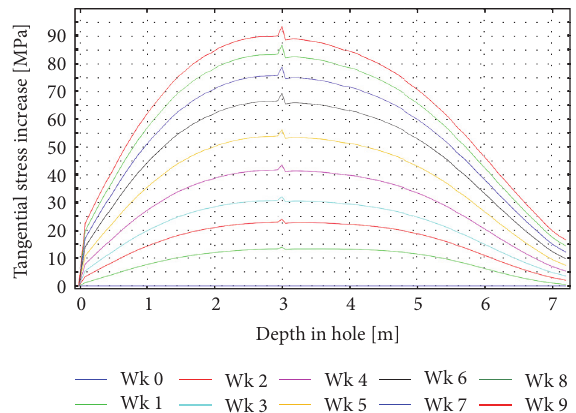
Figure 11: Preliminary model tangential stress increase calculated at the inner surface of the rock mass (weeks 0–9).